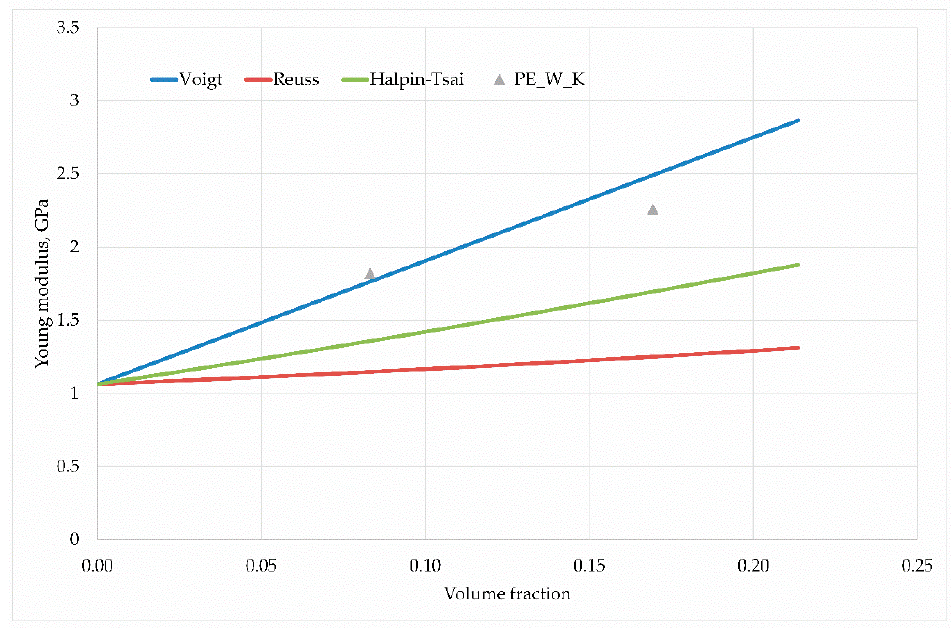
Figure 12. Young’s modulus dependence on the wood flour and coco fiber content in the PE Figure 12. Young ’ s modulus dependence on the wood flour and coco fiber content in the PE matrix.